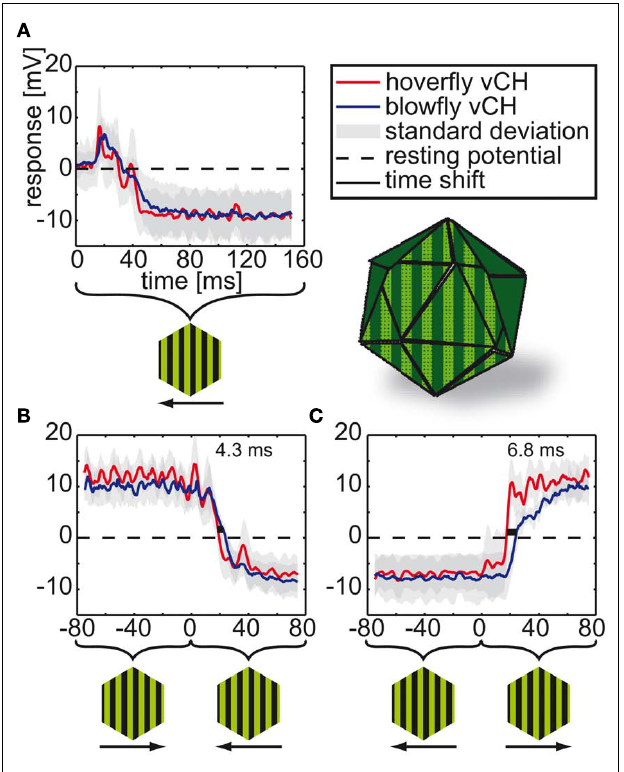
FIGURE 5 | vCH responses to instantaneous velocity changes during spinning drum stimulation. The vCH cells of blowflies and hoverflies were stimulated with a sinusoidal vertical stripe pattern moving in horizontal direction at 2Hz temporal frequency for 1080ms in each direction. Onset to null-direction motion (A) and to direction changes of either polarity (B,C) . Resting potential is marked by the dashed black line.The blue line denotes the Calliphora responses ( N = 5, n = 3–7) and the red line the Eristalis responses ( N = 8, n = 2–10).The gray areas around the lines mark the standard deviations. Light green horizontal lines correspond to time shifts (green numbers) between responses at half-maximal response.The stimulus apparatus is depicted next to the figure legend. Below the time axis the movement direction of the stripe pattern is